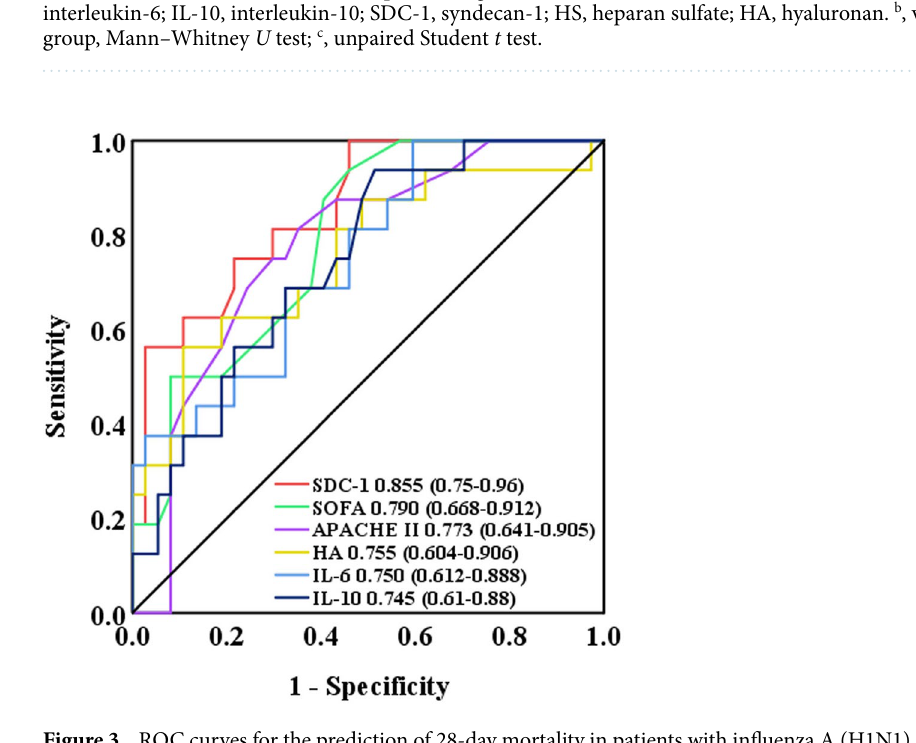
Figure 3. ROC curves for the prediction of 28-day mortality in patients with influenza A